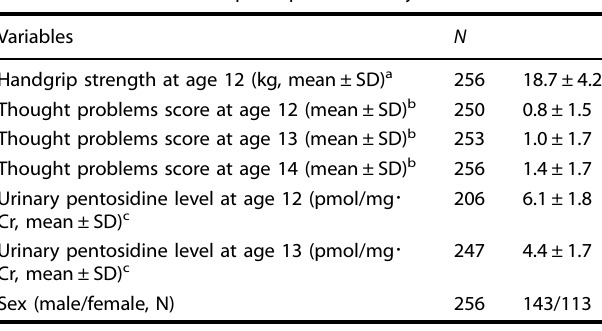
Table 2. Characteristics of participants in Study